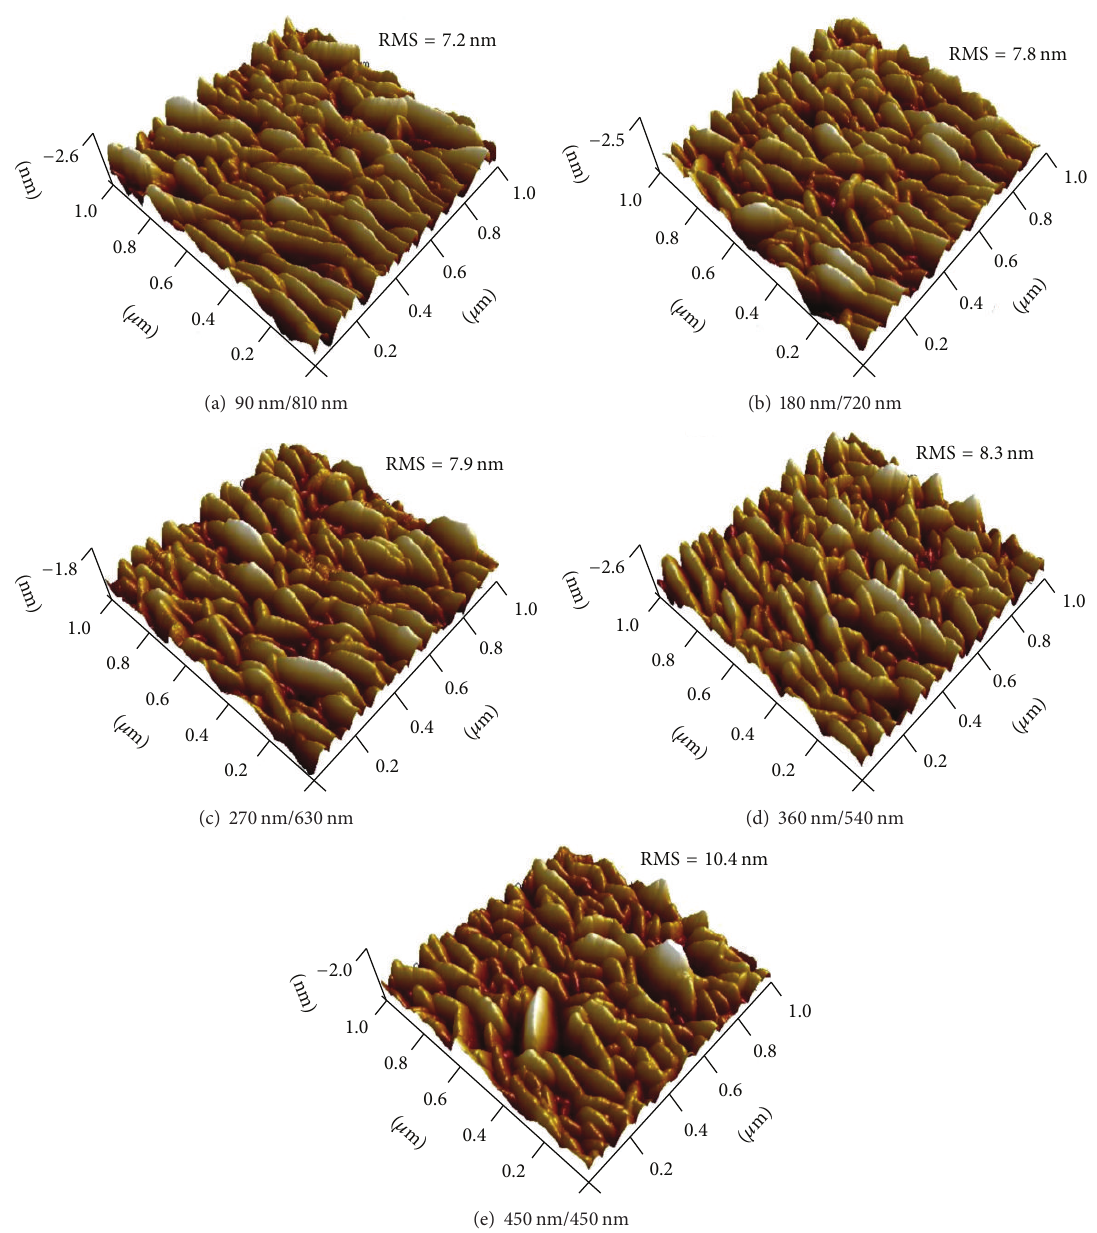
Figure 6: AFM 3D images of bilayer Mo stacks with different thickness ratios of bottom/top layers deposited on soda-lime glass substrates: (a) 90 nm/810nm, (b) 180nm/720 nm, (c) 270 nm/630 nm, (d) 360nm/540 nm, and (e) 450